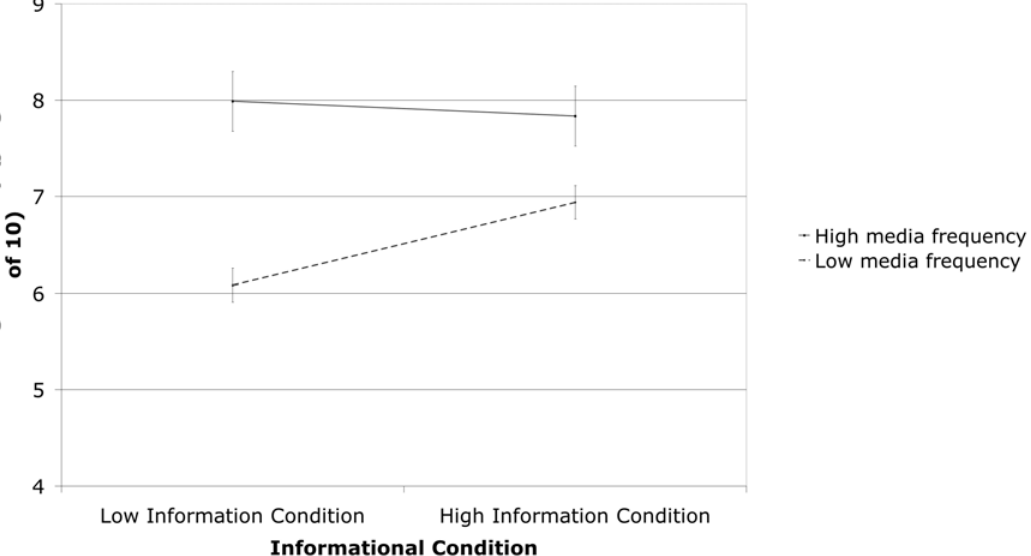
Figure 2. The relationship between Informational Conditions (high of low information) and Media Frequency (high or low) in estimations of severity made by medical students. Error bars indicate Standard Error.